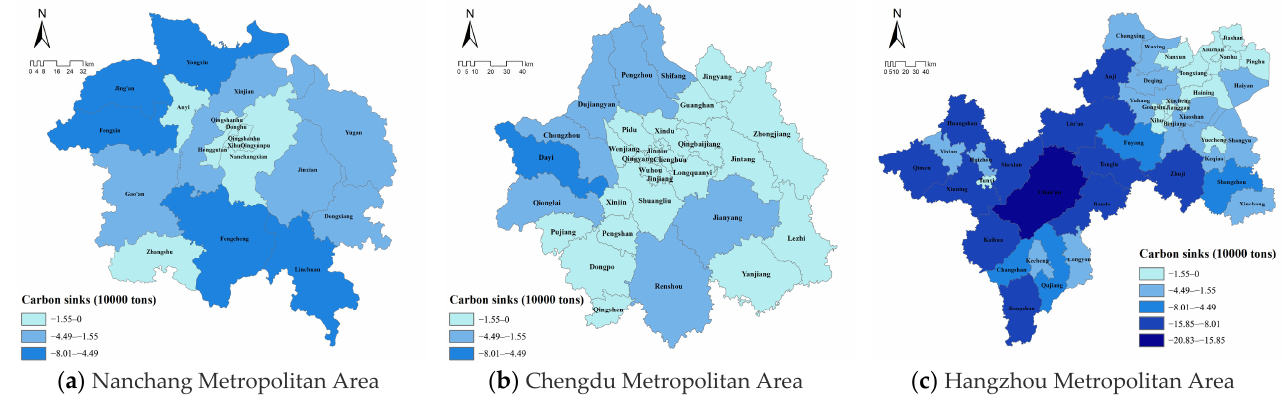
Figure 4. County-level distribution of LUCE sinks in Nanchang, Chengdu, and Hangzhou metropolitan areas.